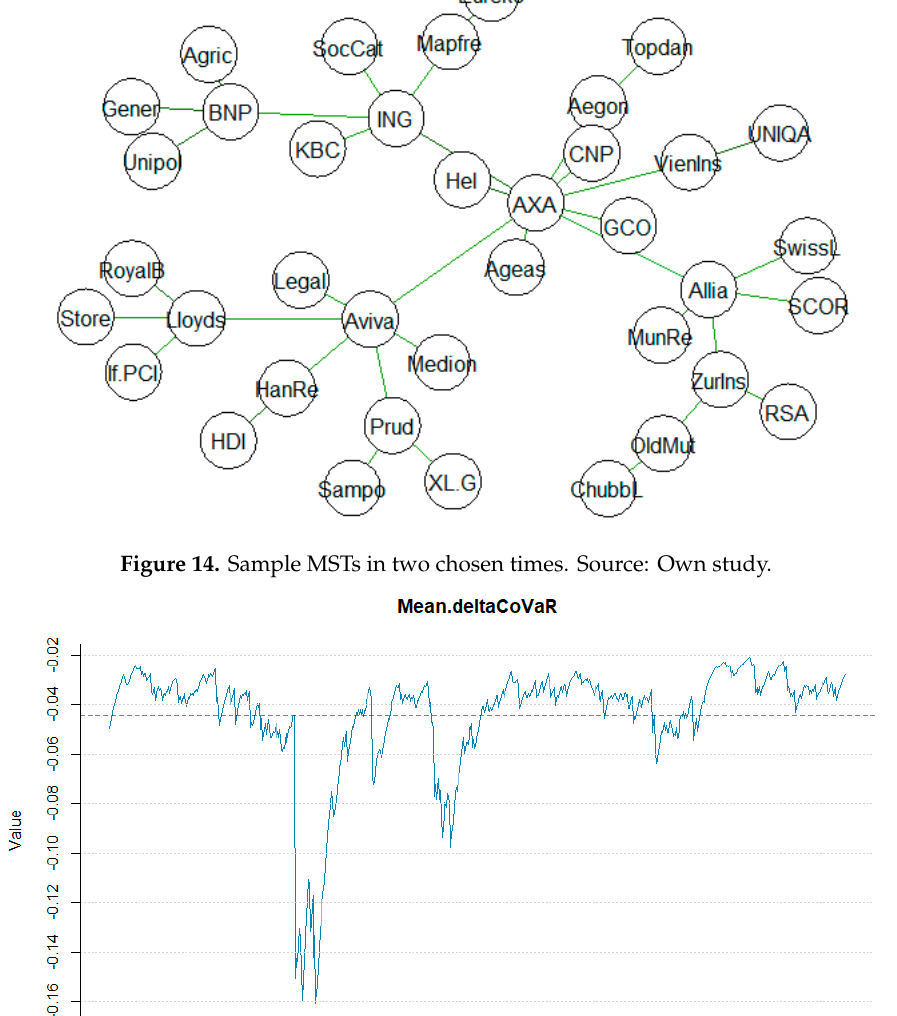
Figure 15. Mean deltaCoVaR. Source: Own study.